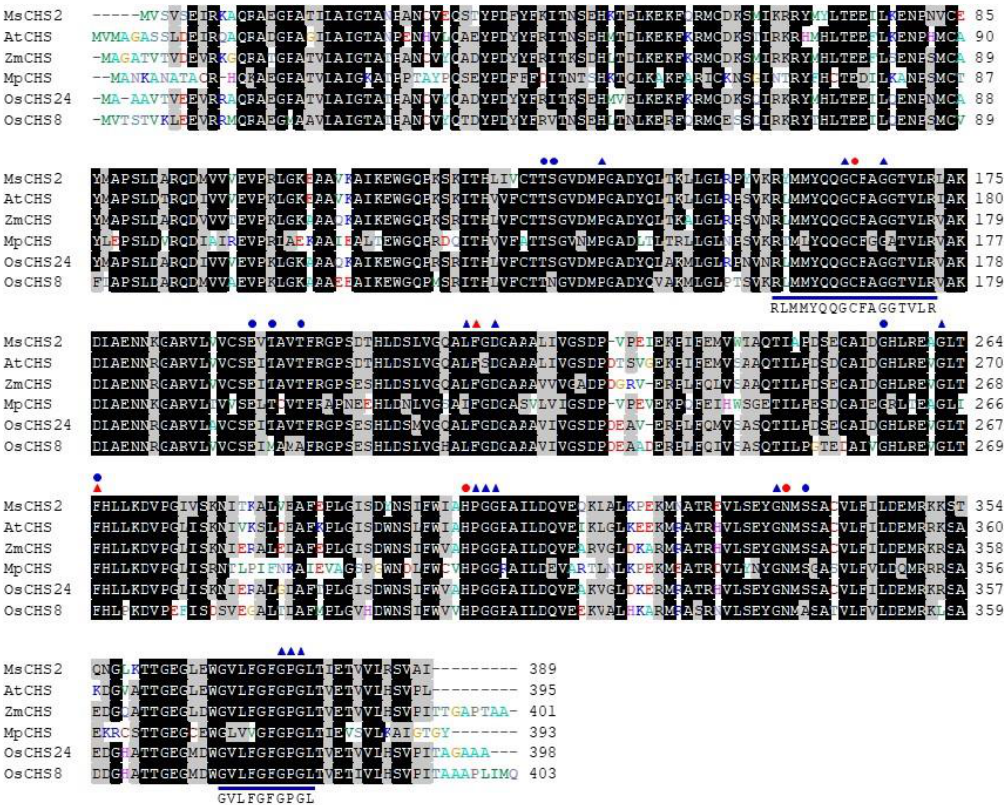
Figure 2. Multiple alignments of amino acid sequences of OsCHSs and other plant CHSs. The amino acid sequences were aligned with Clustal-W. Amino acid residues that are identical or similar are shaded in black and gray, respectively. Red circles indicate catalytic triad residues in CHSs. Residues marked with red triangles are gatekeeper Phe residues. Blue triangles are conserved residues shaping the active site geometry of CHS. The blue circles indicate residues important in the binding of the coumaroyl moiety and the specificity of cyclization reactions in CHSs. The conserved motifs in CHSs are underlined and their consensus sequences indicated. Amino acid sequences of other plant CHSs used were MsCHS2 (P30074), AtCHS (AAB35812), ZmCHS (NP_001142246), and MpCHS